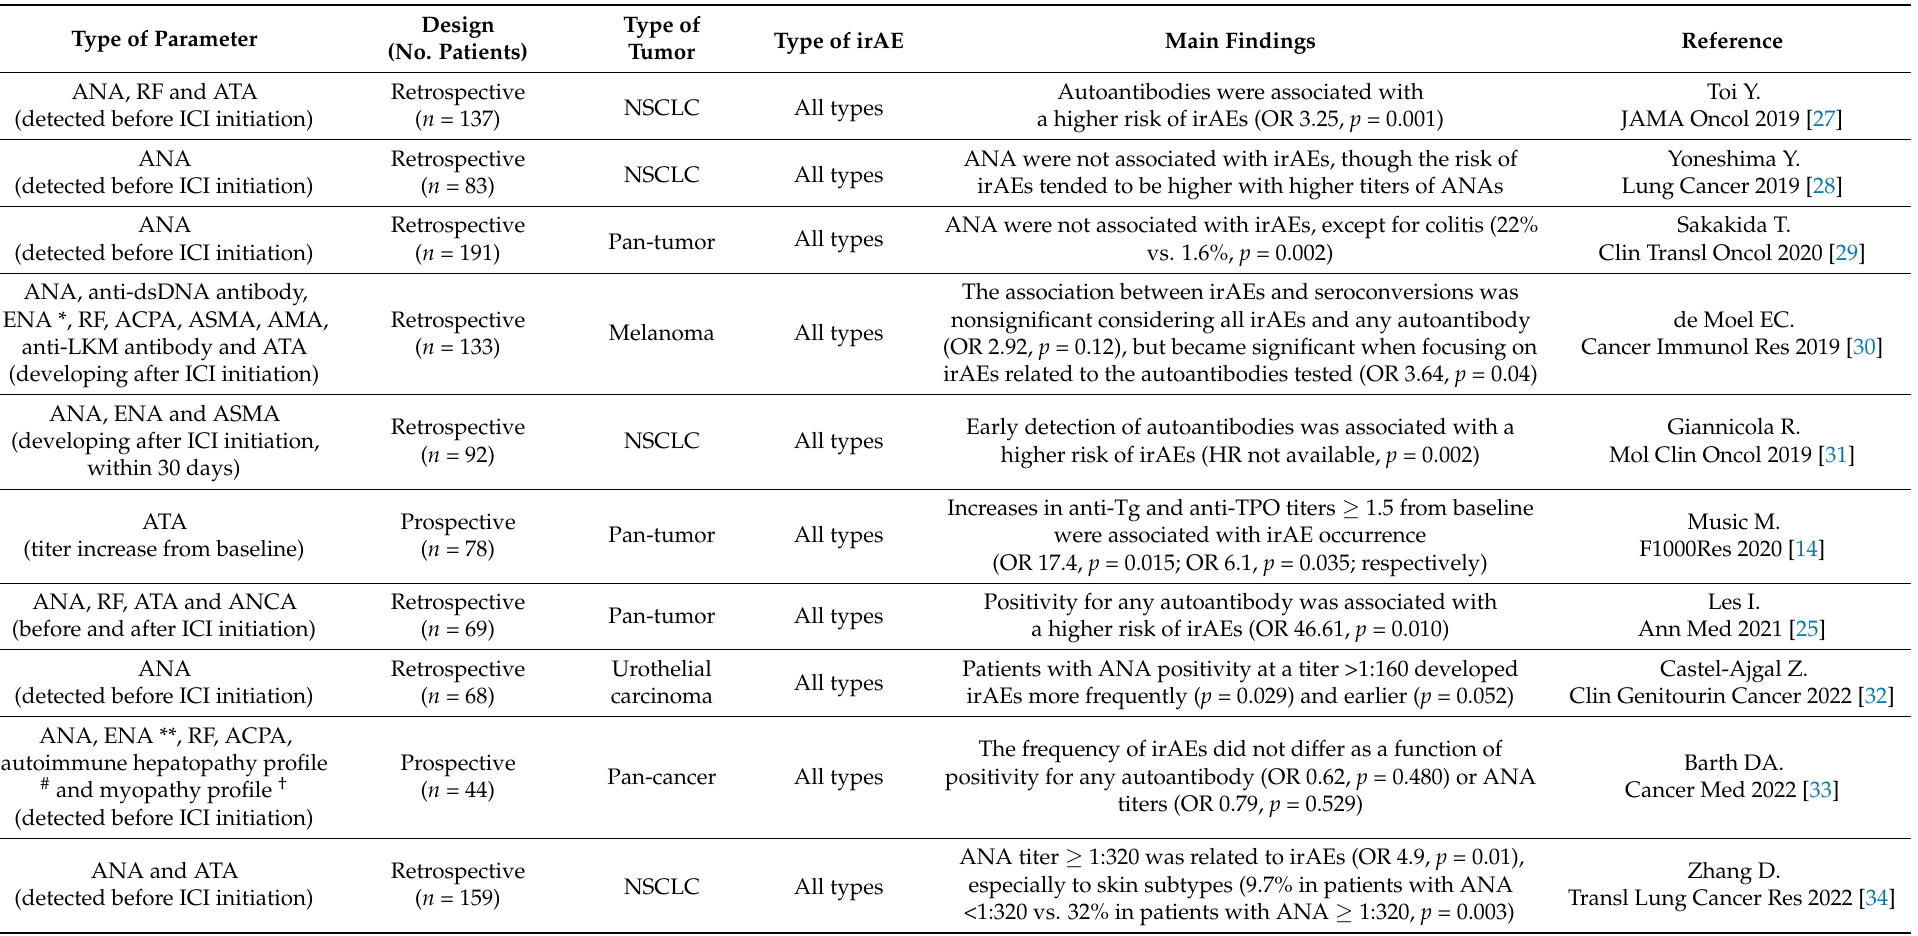
Table 1. Summary of studies on the clinical use of autoantibodies as predictive biomarkers for immune-related adverse events regardless of the specific organ- autoantibody